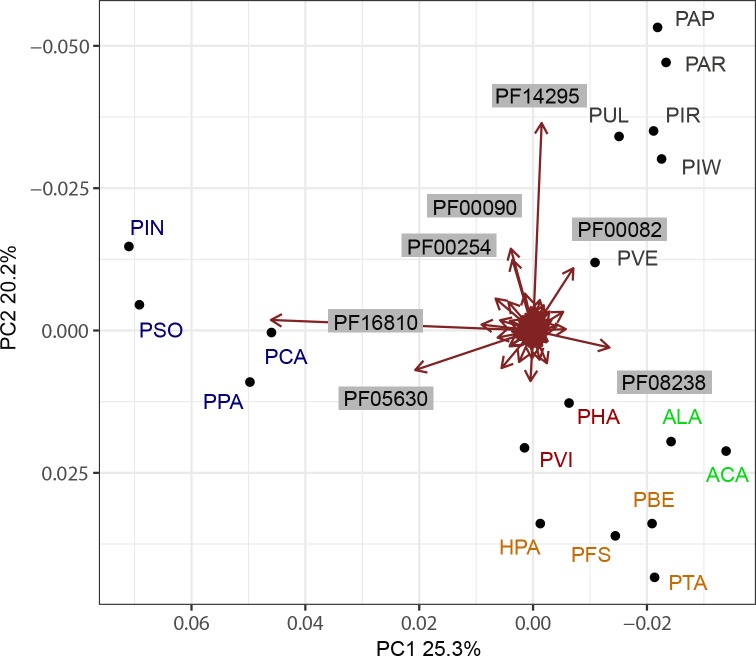
Pfam domains that strongly contribute to the variation in the relative abundance between species.Although many domains contribute to the variation, PF16810, PF05630, PF08238, PF14295, PF00090, PF00254 and PF00082 are the domains that contribute most, as evidenced by the length of their vectors in the biplot.